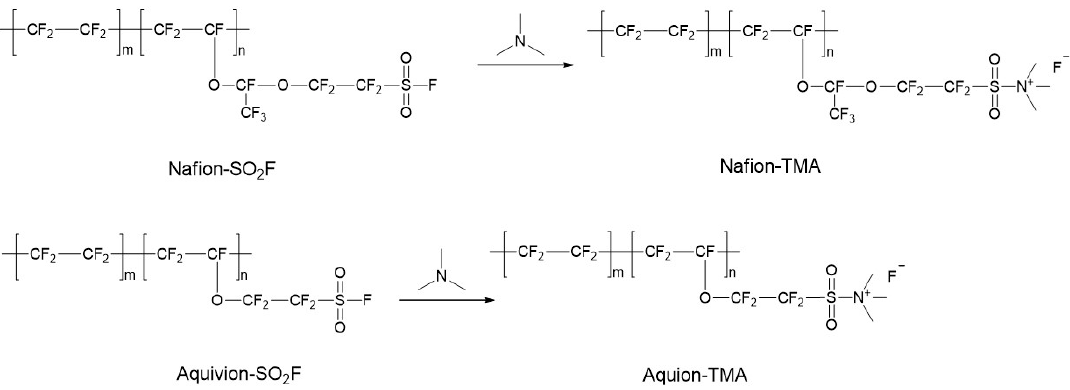
Figure 1. FT-IR spectra of the ( a ) Nafion- and ( b ) Aquivion-based polymers before and after